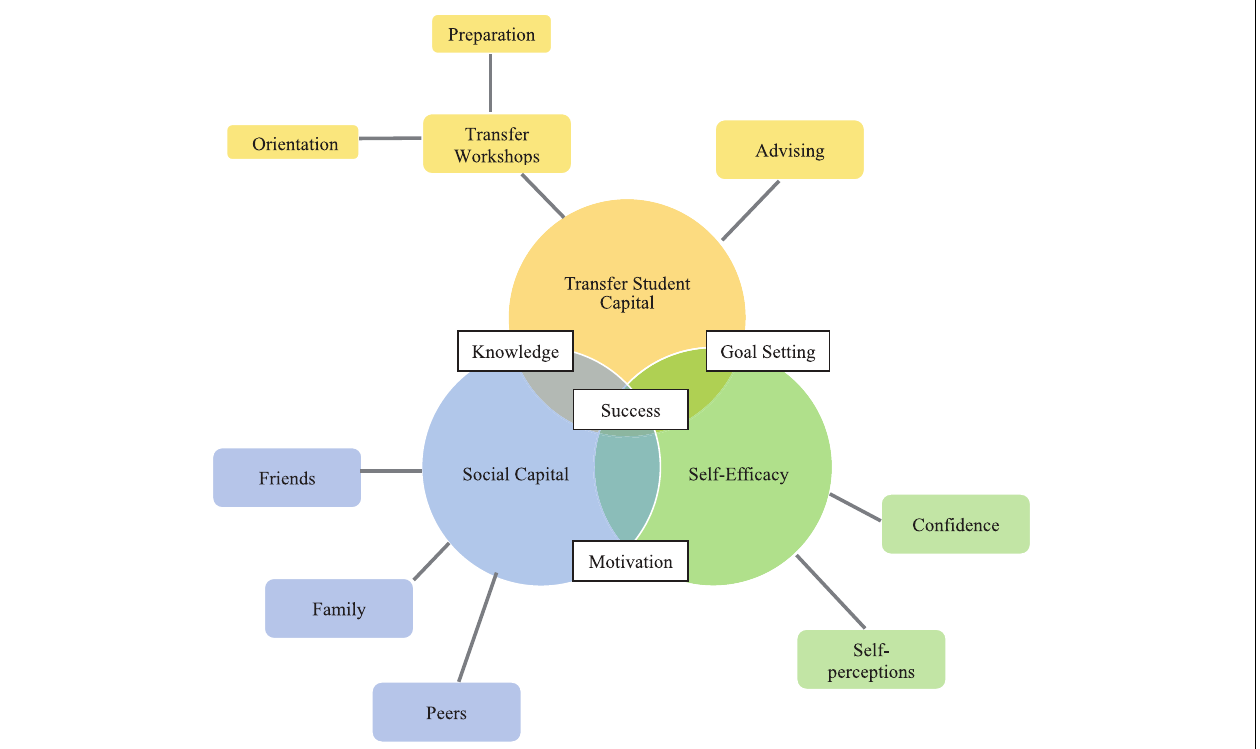
FIGURE 1 | Thematic map, showing the interconnections between Transfer Student Capital (TSC), social capital, and self-efficacy and its relation to transfer student